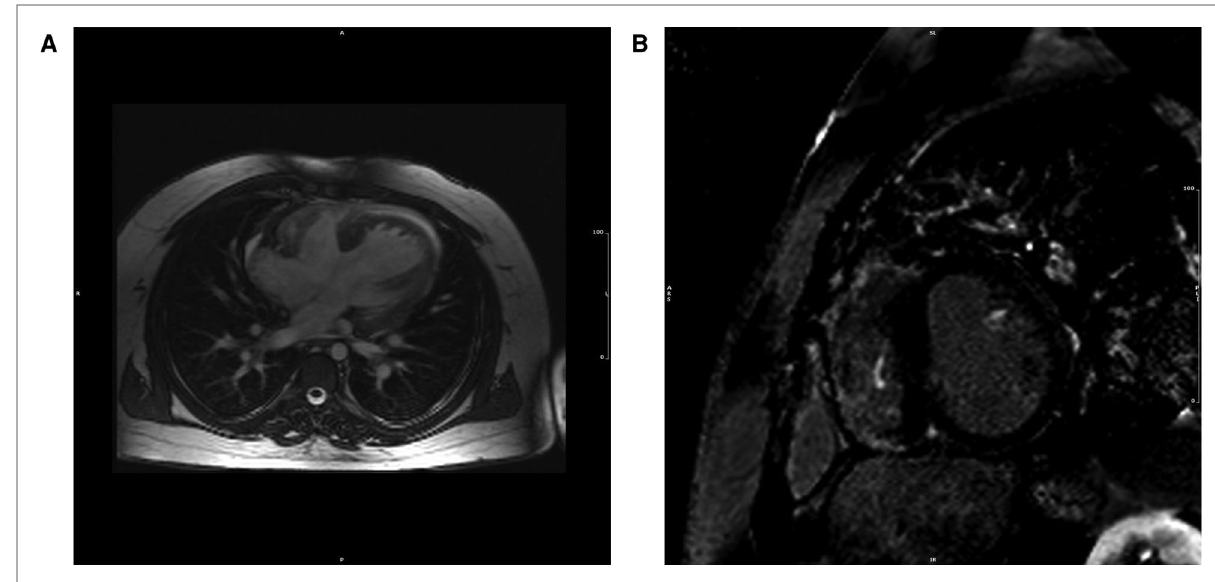
FIGURE 5 CMR cine ( A ) and LGE ( B ) image from 27-year-old patient Eisenmenger syndrome because of an untreated ventricular septal defect, showing extent in right ventricular free wall, as well as in the insertion points and in the left ventricle ’ s papillary muscles. The patient developed ventricular arrhythmias in the follow-up and died suddenly at the age of 33.